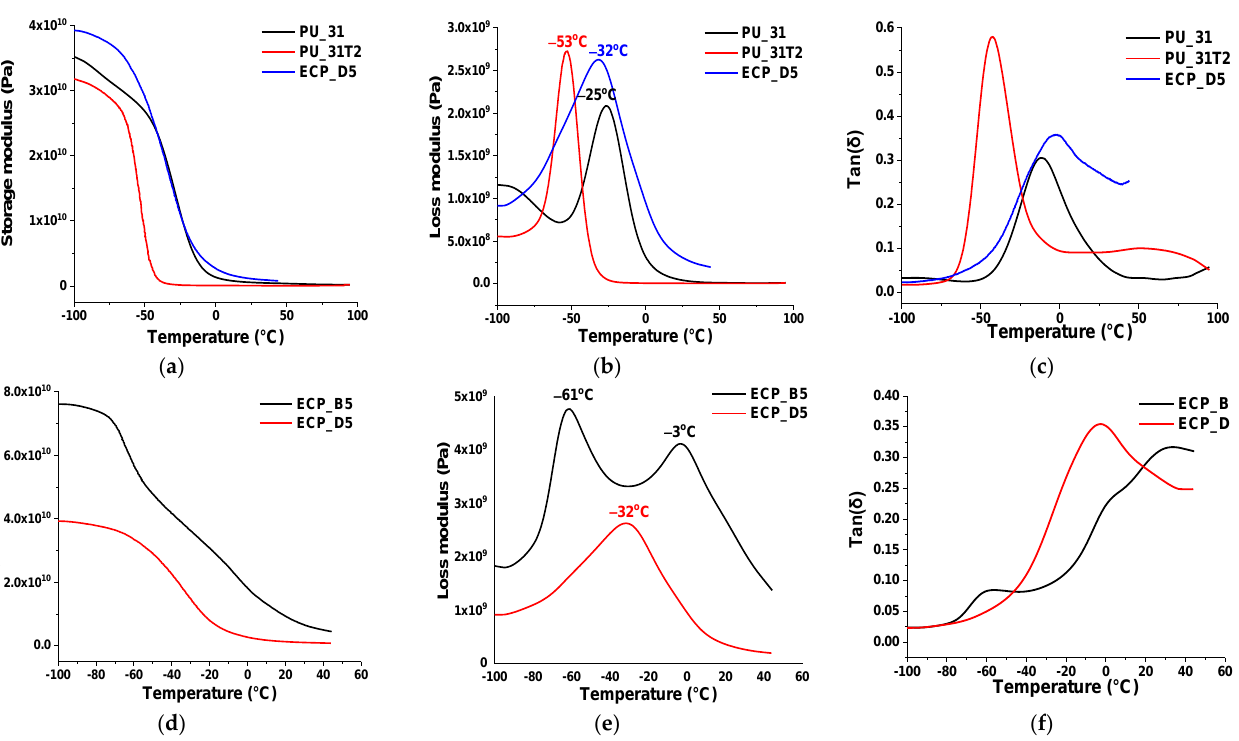
Figure 8. Dynamic mechanical analysis for polyurethanes and composite propellants. ( a , d ) Storage modulus for polyurethane films and for the corresponding composites; ( b , e ) Loss modulus for polyurethane films and for the corresponding composites; ( c , f ) Tan delta plots for polyurethane films and for the corresponding composites.